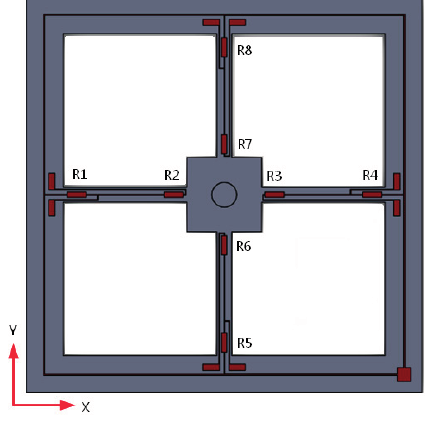
Figure 4. Diagram of the distribution of the